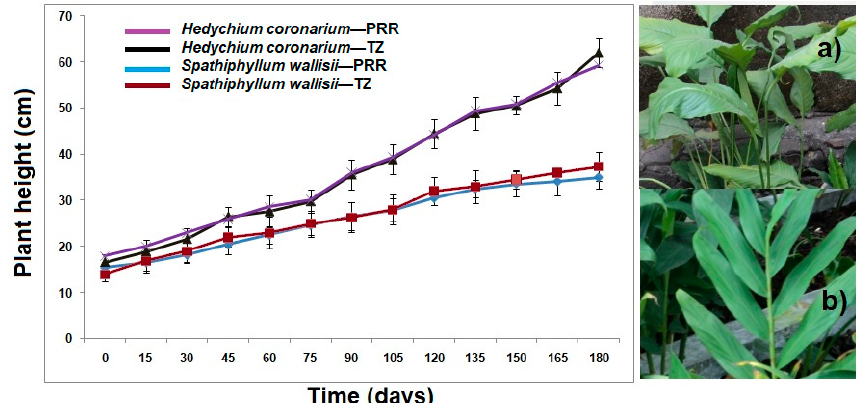
Figure 3. Vegetation growth in study. ( a ) Spathiphyllum wallisii , and ( b ) Hedychium coronarium.